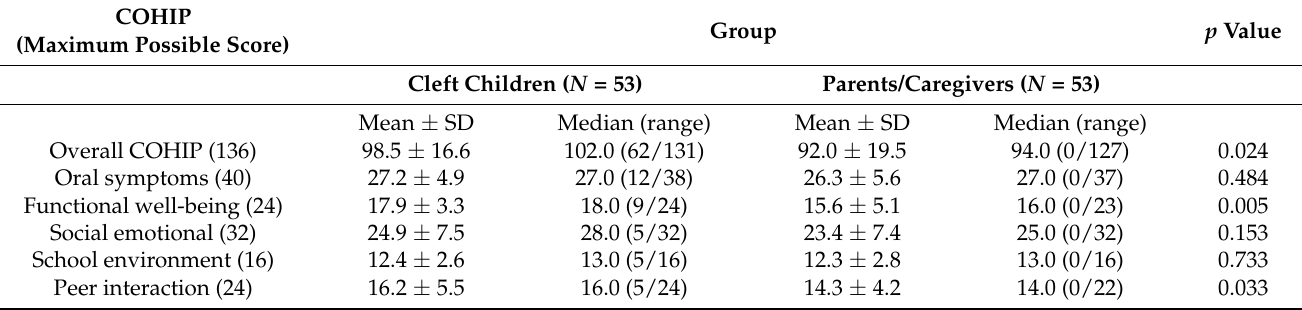
Table 2. Comparison of COHIP overall and subscale scores between cleft children and parents.